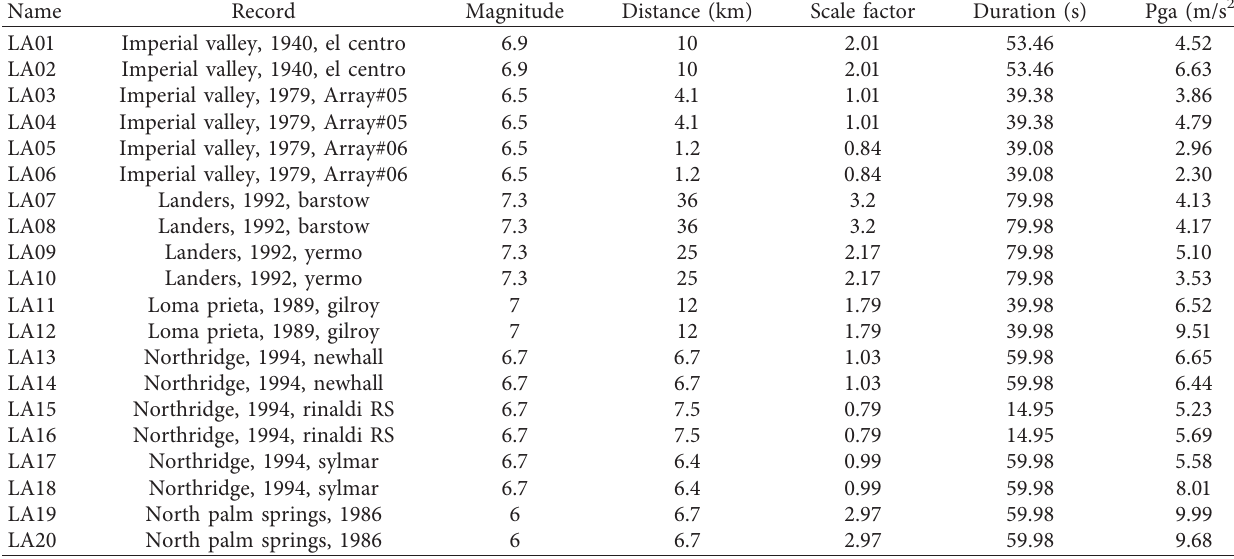
Table 1: Los Angeles earthquake records with a probability of exceedance of 10% in 50 years.